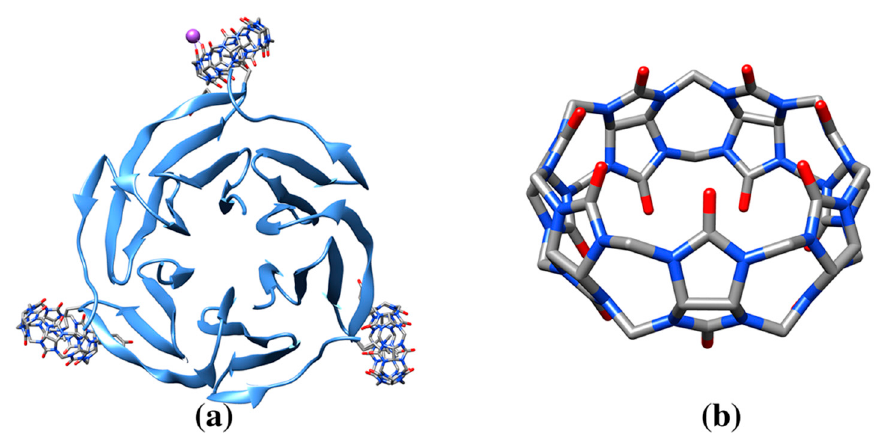
Figure 8. ( a ) Ribbon drawing of fucose binding lectin protein in complex with cucurbit[7]uril (pdb entry 6f7w). Cucurbit[7]uril molecules show selective binding towards post translational modifications of a surface lysine residues. One of the bound cucurbit[7]uril molecules interact with a sodium ion (Na purple). ( b ) Cucurbit[7]uril molecule (cif code QQ7).